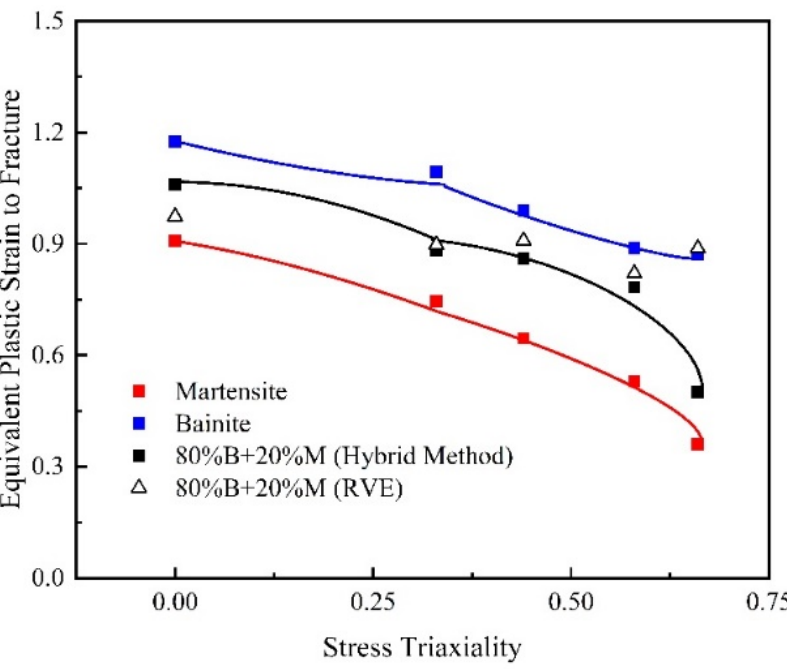
Figure 19. Predicted damage curves for B/M mixed microstructure and compared with damage curves of pure bainite and martensite (blue indicates bainite specimens, red indicates martensite specimens, and black indicates 80%B + 20%M specimens).